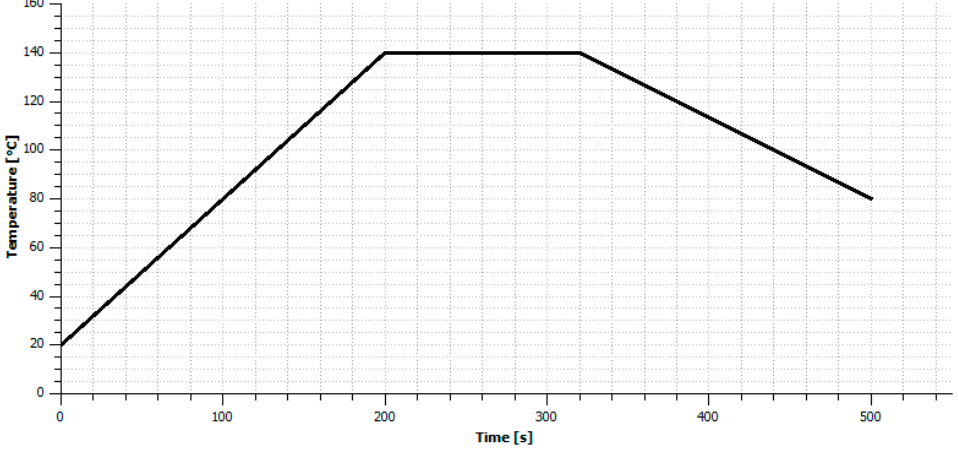
Figure 5. Temperature profile used in reflow soldering process in a convection oven.